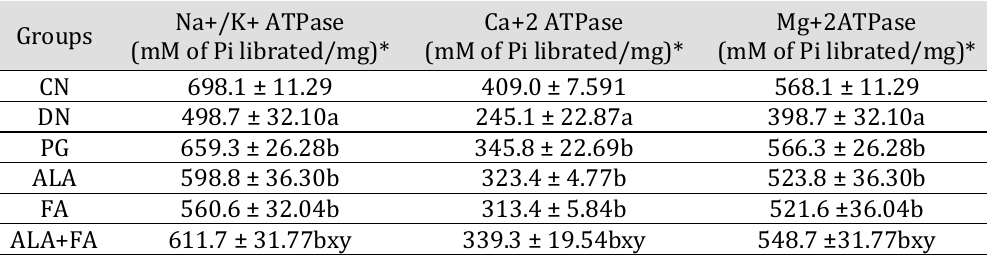
Table 3. Effect of ALA, FA, and their combination on membrane-bound phosphatases